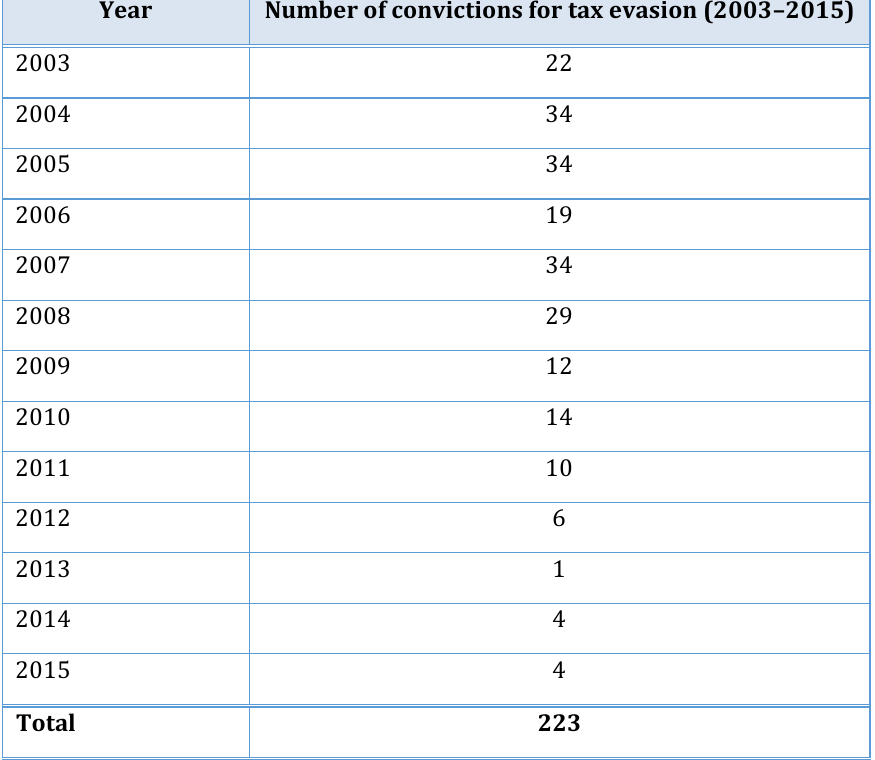
Table 1. Criminal convictions for tax evasion in Argentina